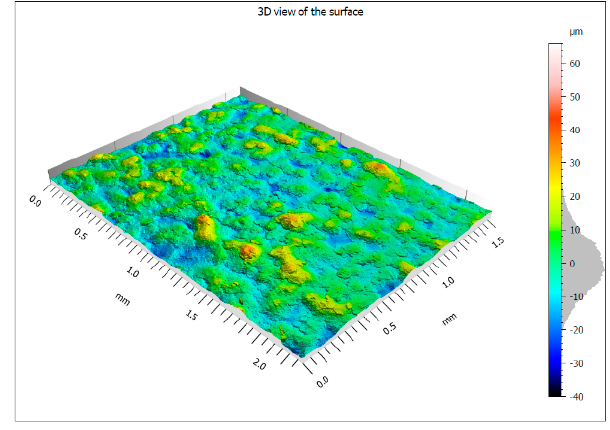
Figure 6. 3D surface roughness map for sandblasted sample.